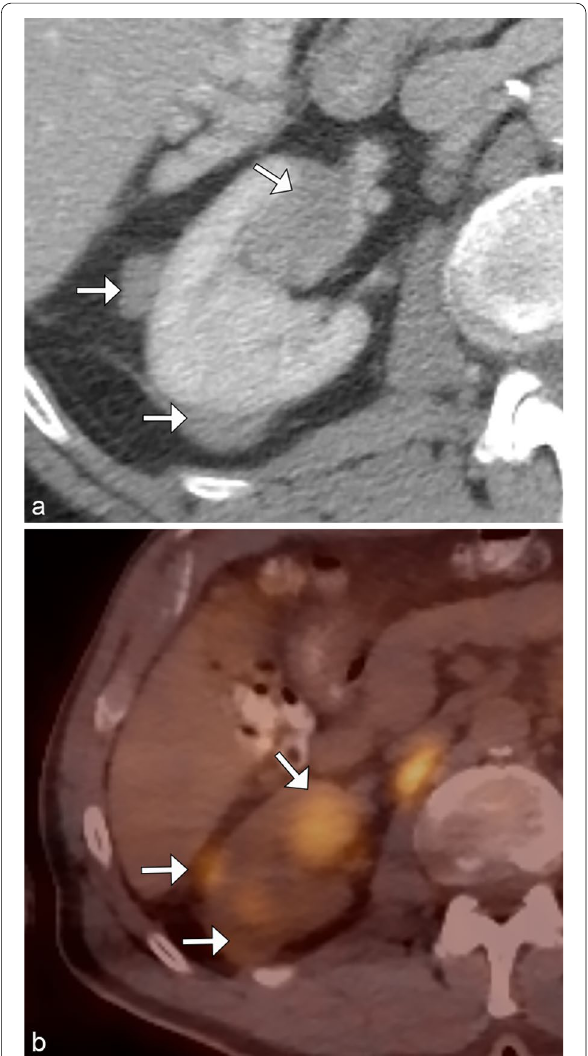
Fig. 1 Multiple renal masses of renal lymphoma . Axial contrast CT ( a ) demonstrates small, hypoenhancing masses (arrows) in the right kidney. Axial fused PET/CT image ( b ) demonstrates F18-FDG avidity of these masses (arrows) consistent with lymphoma in this patient with known diffuse large b-cell lymphoma